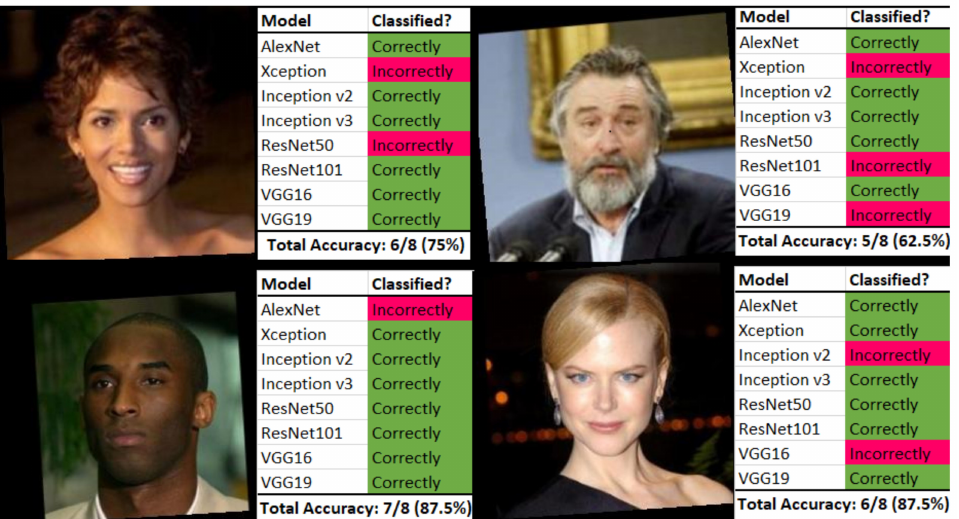
Figure 9. Example of correctly and incorrectly identified images by CNN